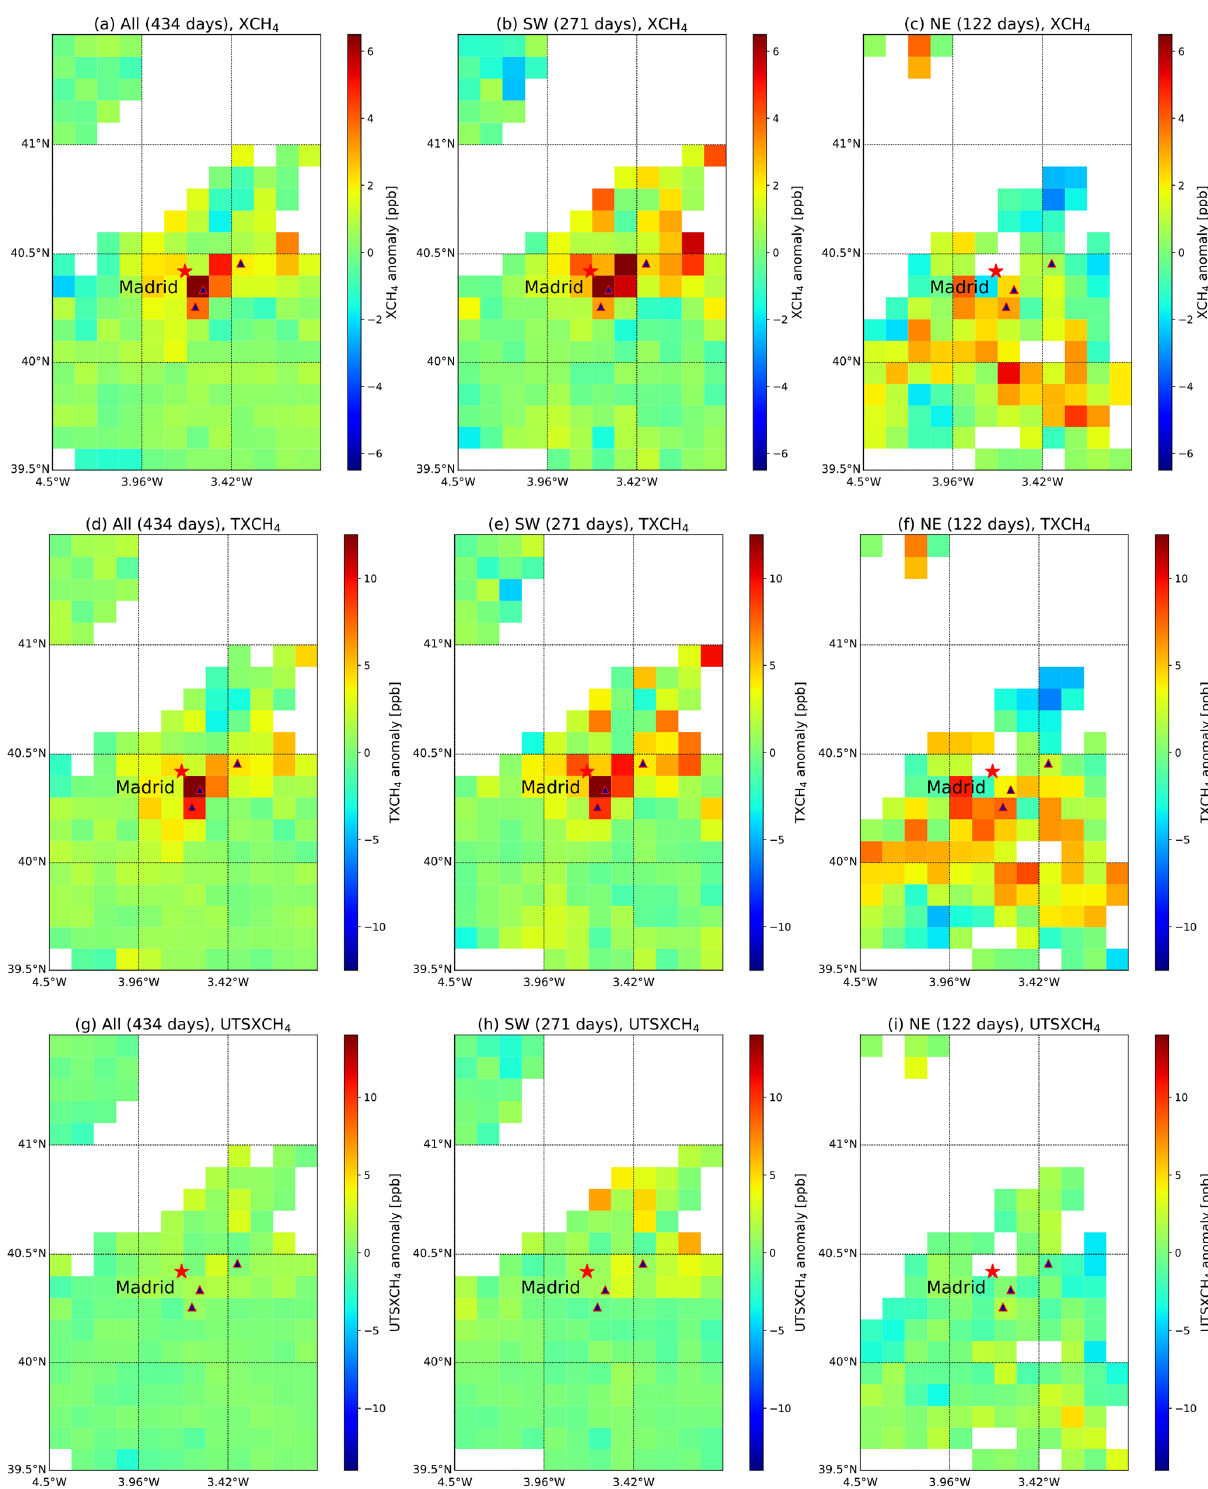
Figure 8. (a–c) XCH 4 , (d–f) TXCH 4 and (g–i) UTSXCH 4 anomalies averaged for all days, days with SW wind and NE wind directions. The triangle symbols represent the location of waste